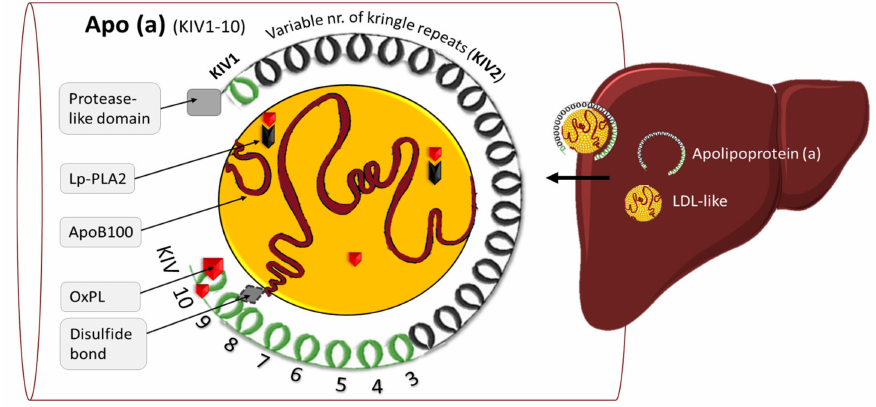
Figure 2. Schematic view of Lp(a). Abbreviations: apo(a), apolipoprotein (a); OxPL, oxidized phospholipids; Lp-PLA2, lipoprotein-associated phospholipase A2; KIV, kringle